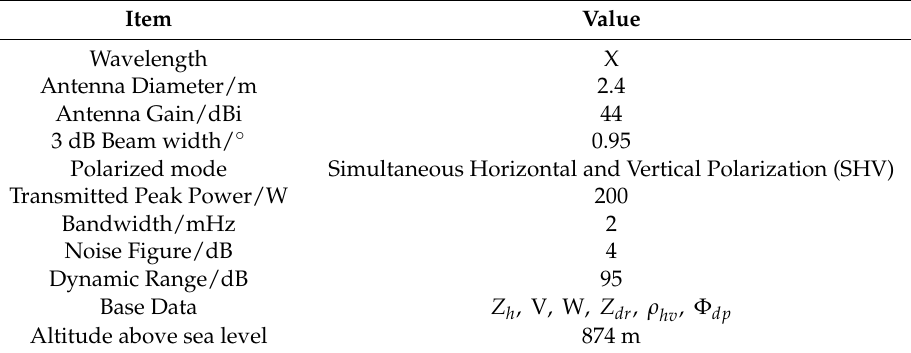
Table 1. System characteristics of the XPRAD radar.